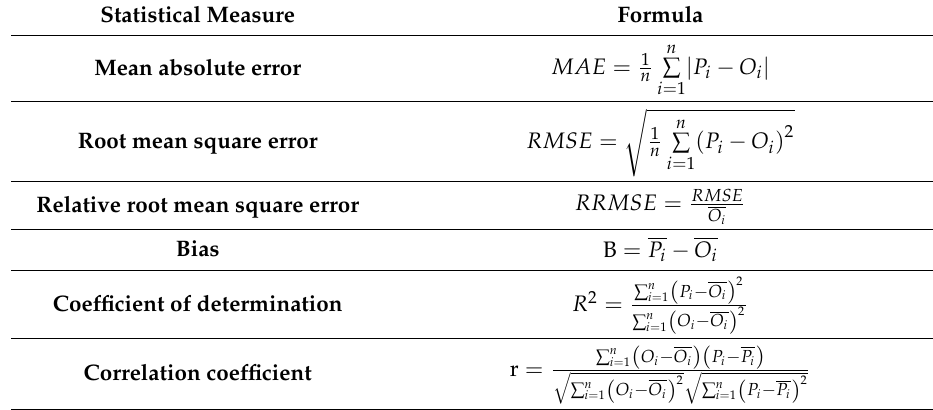
Table 3. Statistical measures. Note: P i is predicted, O i is observed and n is the number of